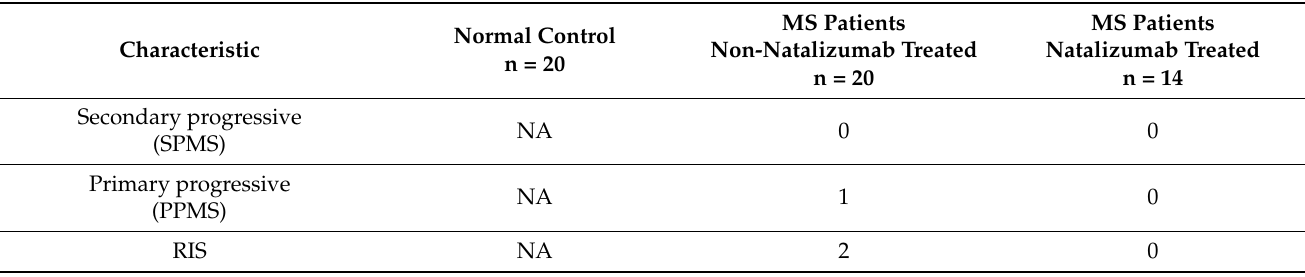
Table 4. PML patients and JCPyV viremia. PML 1 is serum from a patient with MS/PML treated